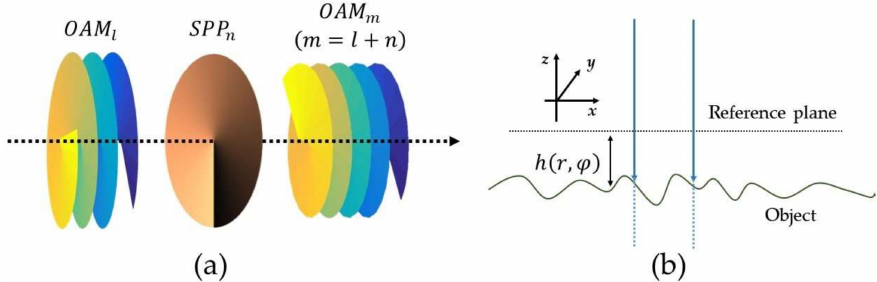
Figure 9. ( a ) Mode conversion with a SPP. ( b ) Analysis of a rough surface.